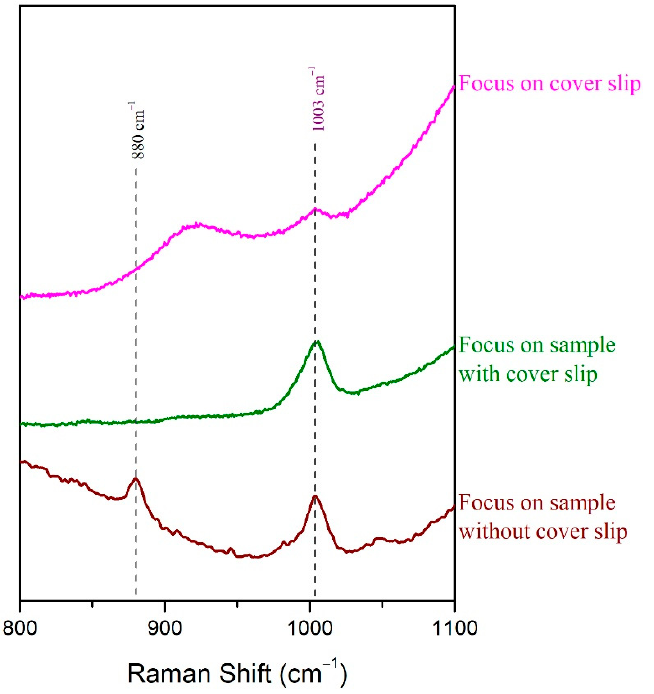
Figure 7. The Raman spectrum of 5 μ L/mL ethanol in human urine after placing the sample in the cavity of the gold-coated glass slide was recorded without and with being covered with a micro- scope cover slip. Two different focus levels were tested when the cover slip was